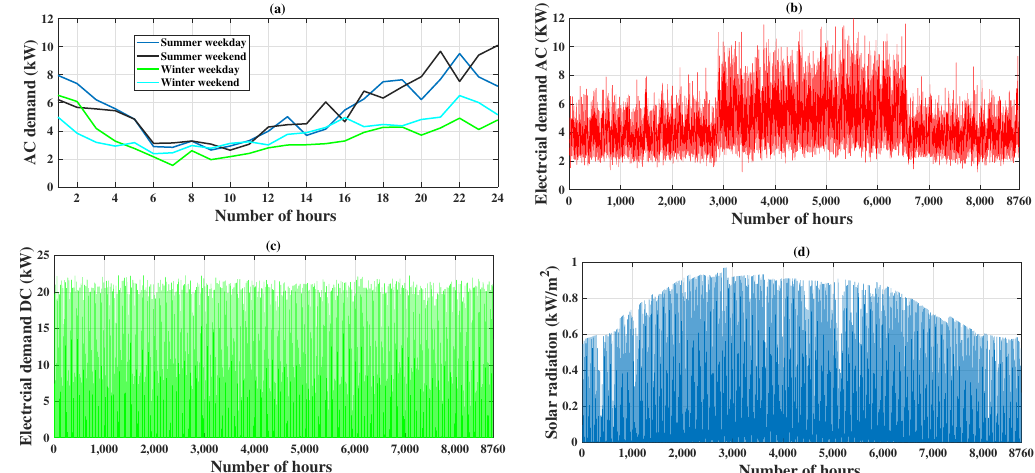
Figure 3. ( a ) Load profile of the study area; ( b ) electrical demand (AC) yearly; ( c ) electrical demand (DC) yearly; ( d ) solar radiation yearly.